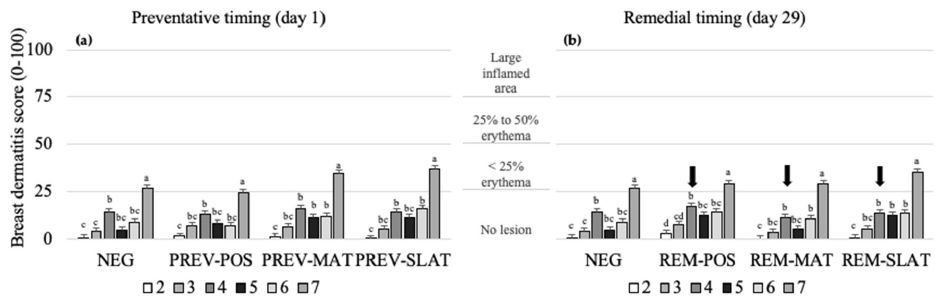
Figure 4. Mean breast dermatitis scores (raw means ± SEM) of birds that received ( a ) preventative provision of the flooring treatments (PREV) ( b ) or birds that received remedial provision of the flooring treatments (REM): negative control (NEG (presented twice)), clean litter (POS), iodine mat (MAT), or iodine mat with slatted floor (SLAT) during weeks 2 through 7 of age. Scores are on a 0–100 tagged analog scale (tVAS), with increasing scores representing a worsened condition (the “tags” on the VAS are indicated by the horizontal gridlines at each 25-point increase). The arrows in (b) indicate the timing application of the remedial treatments. Means in a flooring × timing treatment combination with di ff erent superscripts ( a–d ) di ff er significantly at p <